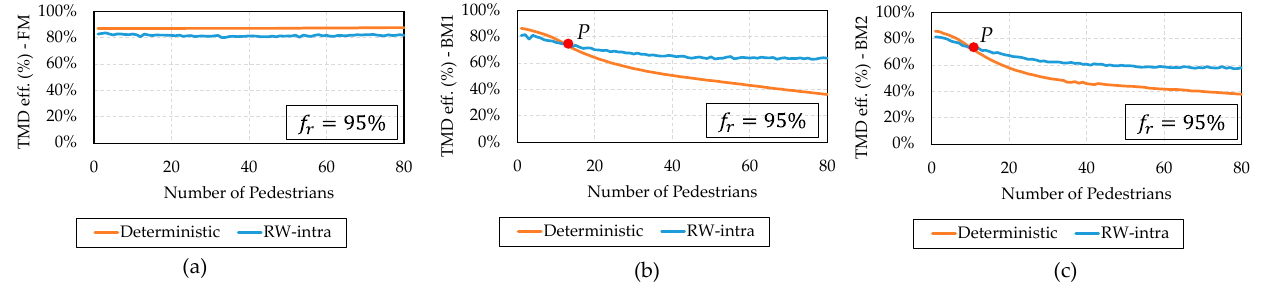
= 95%. ( a ) FM, ( b ) BM1, and ( c )